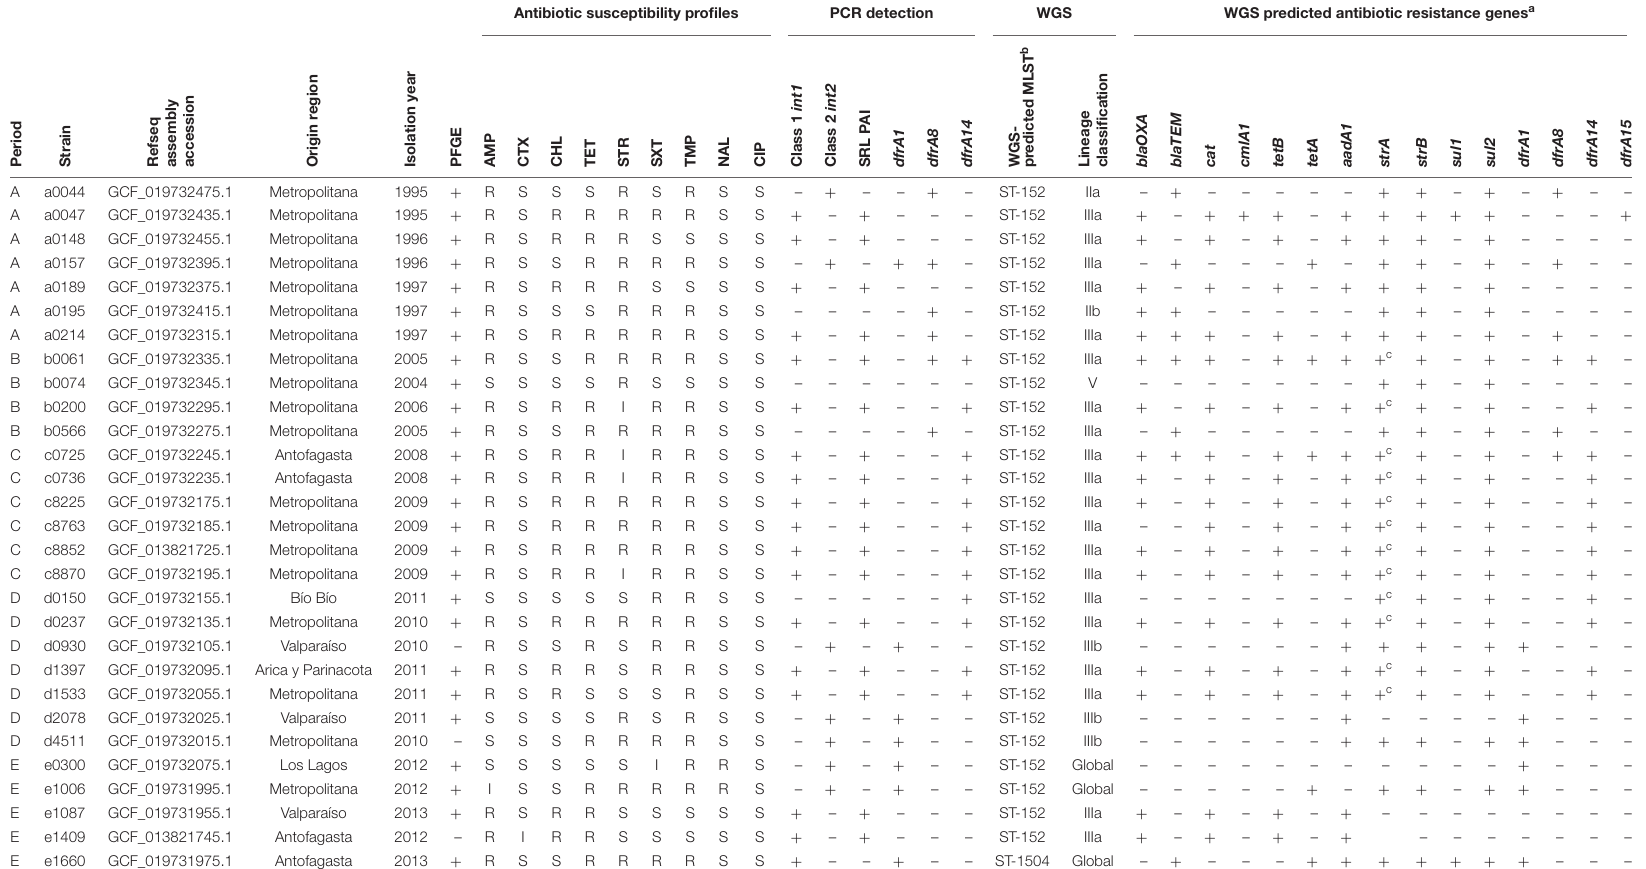
TABLE 2 | Phenotypic and genotypic characterization of 29 WGS Chilean Shigella sonnei